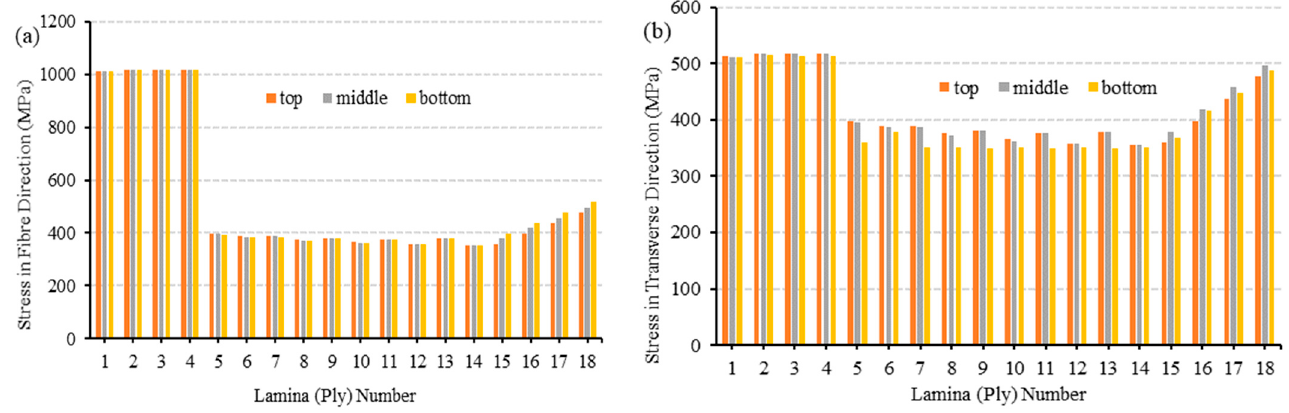
Table 9. Riser deformation and liner stress during collapse event’s preliminary design.